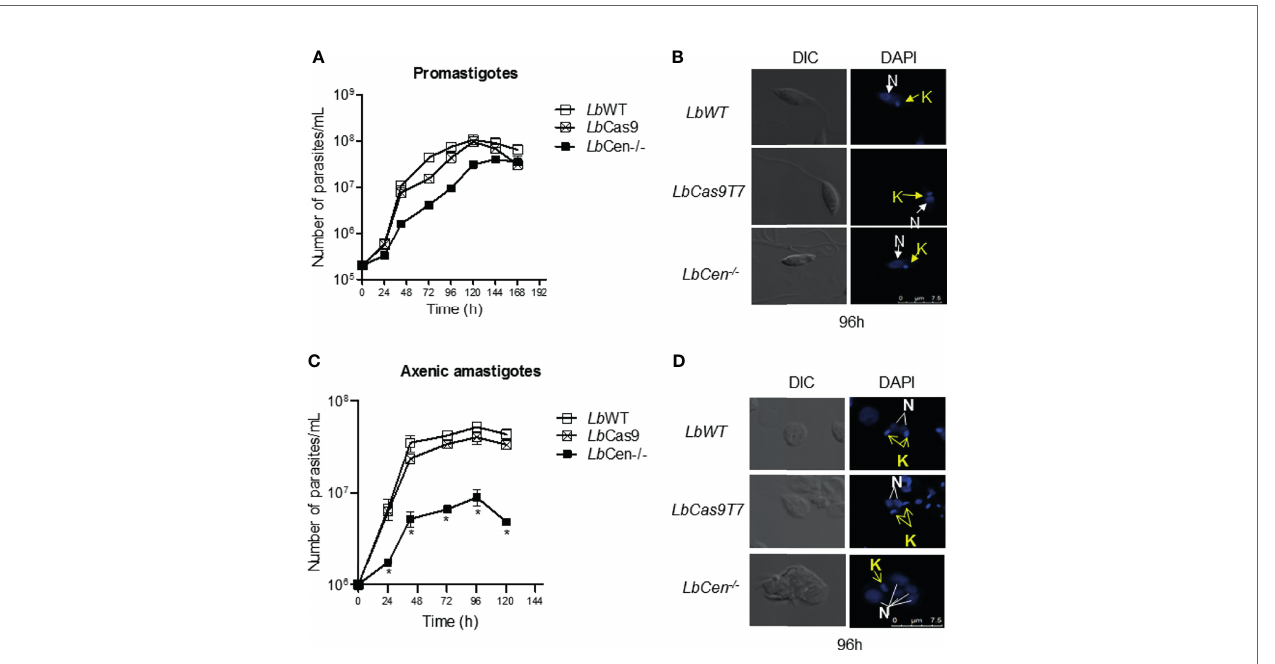
FIGURE 5 | Kinetics of LbCas9T7 and LbCen − / − promastigote growth in vitro . (A) Promastigote cultures were started at 5 × 10 5 parasites/ml and were maintained at 26 °C for 7 days in supplemented Schneider media. Parasite numbers were determined daily by counting using a hemocytometer. Data is plotted as mean ± SEM and is from a representative experiment, performed in triplicate. (B) DIC and fl uorescent (DAPI) representative micrographs of Lb WT, LbCas9T7 , and LbCen − / − promastigotes after 96 h of culture. (C) Axenic amastigote cultures were started at 1 × 10 6 parasites/ml and were maintained at 34°C for 5 days in supplemented Schneider media, pH 5.5. Parasite numbers were determined daily by counting using a hemocytometer. Data is plotted as mean ± SEM, and is from a representative experiment, performed in quadruplicate, *p < 0.05. (D) DIC and fl uorescent (DAPI) representative micrographs of Lb WT, LbCas9T7 , and LbCen − / − amastigotes after 96 h of